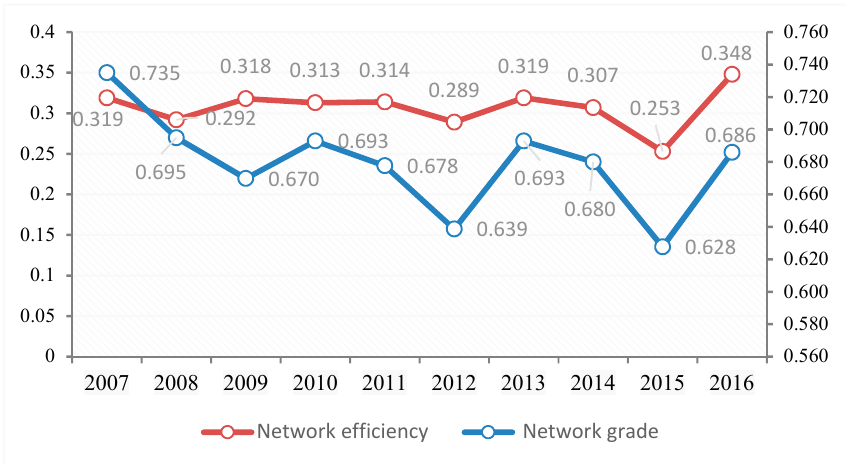
Figure 10. The e ffi ciency and grade of the ANTCE network. Figure 10. The efficiency and grade of the ANTCE network.